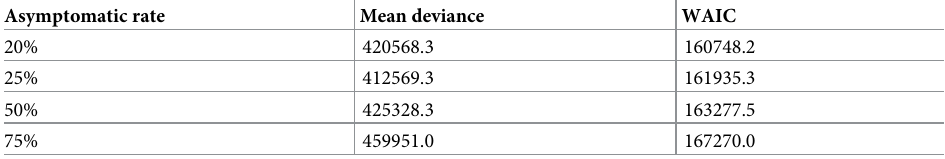
Table 3. Asymptomatic rate results: South Carolina.